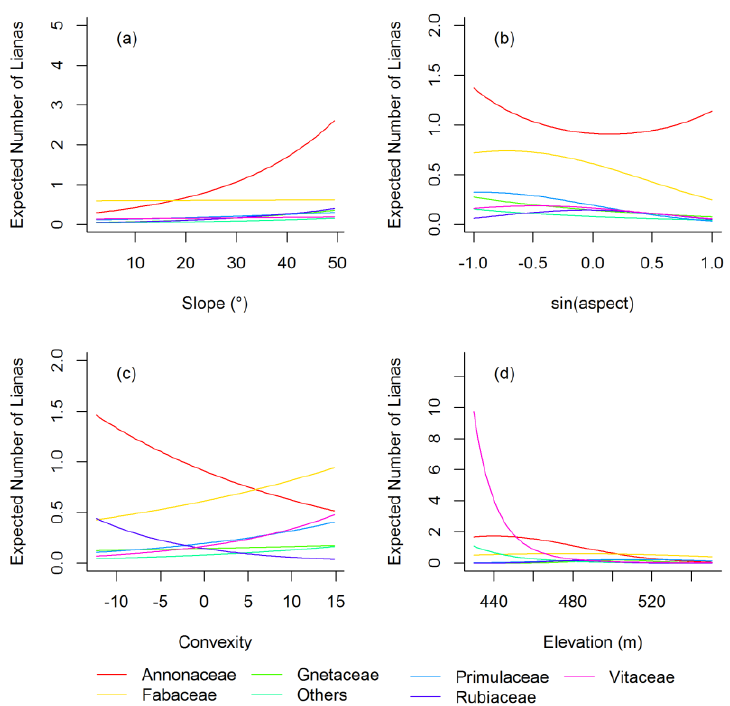
Figure 2. The expected number of lianas in relation to topographic variables under their observed ranges in the 20 ha subtropical forest dynamic plot in China. These curves were all obtained by the final generalized linear model fitted for lianas abundance in a 20 m × 20 m quadrat with a log link function against the family which the lianas belong to, and the interactions of family with slope, sin(aspect), convexity, and elevation of the quadrat. A Poisson distribution was set for the response variable. Table 2. The contribution of each variable to the reduction in deviance in the final model for liana abundance as a function of Family and its interactions with the linear and quadratic terms of four topographic variables, which were slope, sin(aspect), convexity, and elevation using a generalized linear model assuming a Poisson distribution for the response variable. “Family” was a factor, with levels of Annonaceae, Fabaceae, Gnetaceae, Primulaceae, Rubiaceae, Vitaceae, and Others. The level of Others included all families of lianas with fewer than 30 individuals in the plot.